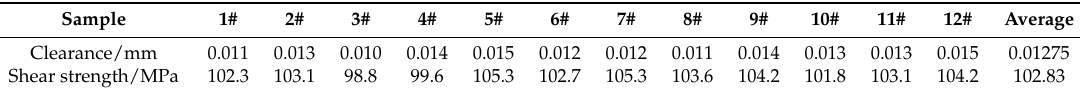
Table 4. The shear strength for the samples brazed with side solder feeding with large clearances.